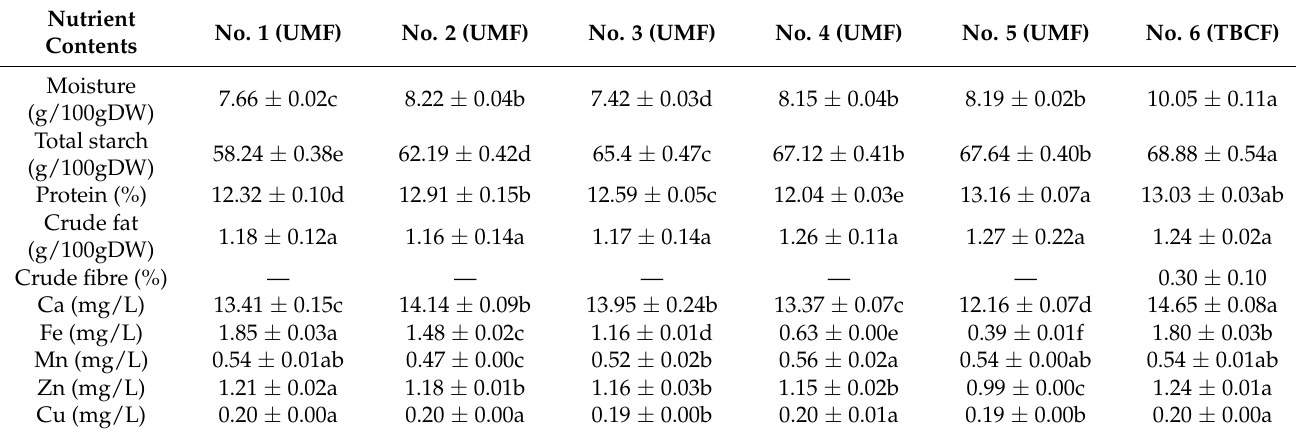
Table 3. Effects of airflow ultrafine-grinding on the basic components in Tartary buckwheat flour 1